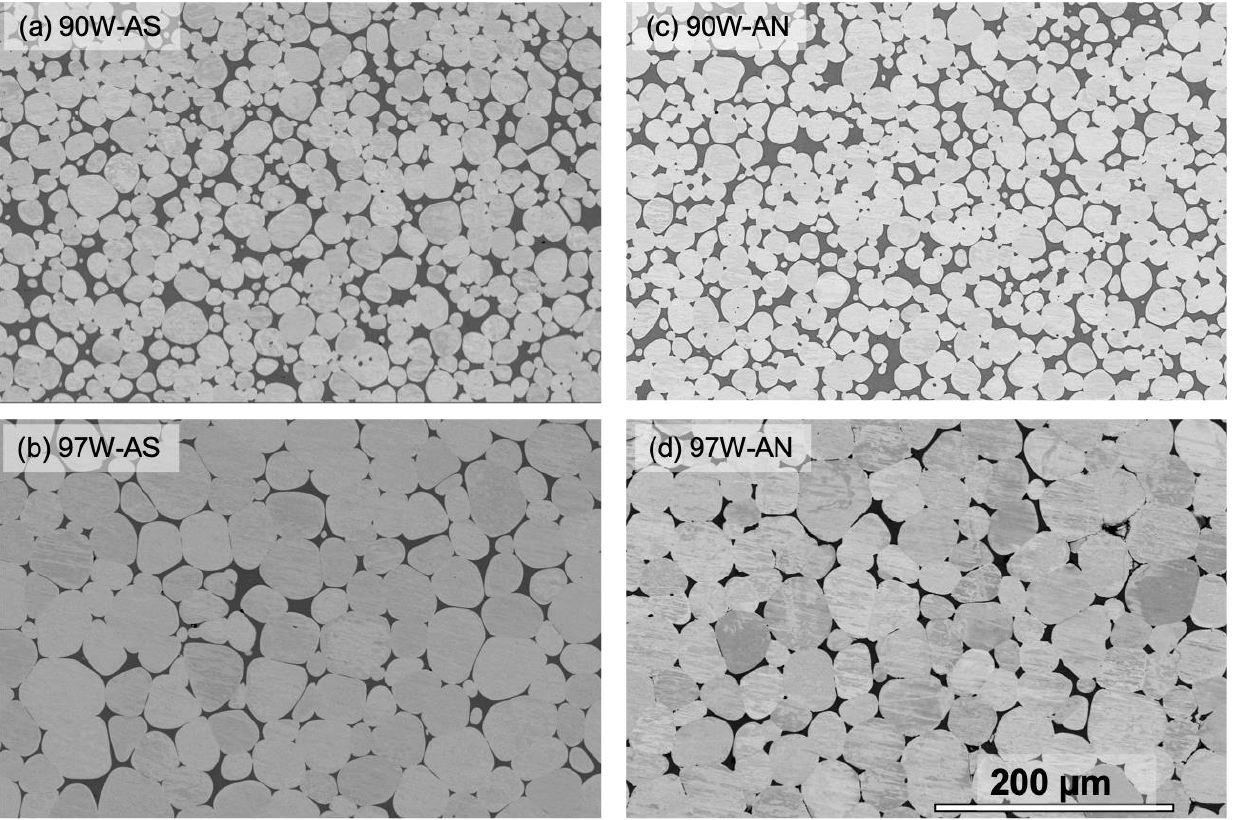
Figure 1. Low magnification SEM images of 90 and 97W WHAs: ( a , b ) before annealing; ( c , d ) after annealing. The scale bar is 200 µm for all cases. Table 2. The W-particle diameter, D W , DP surface area %, W – W contiguity, DP thickness, and t/D W for the as-sintered (AS) and 1300 °C/24 h annealed (AN) WHAs.